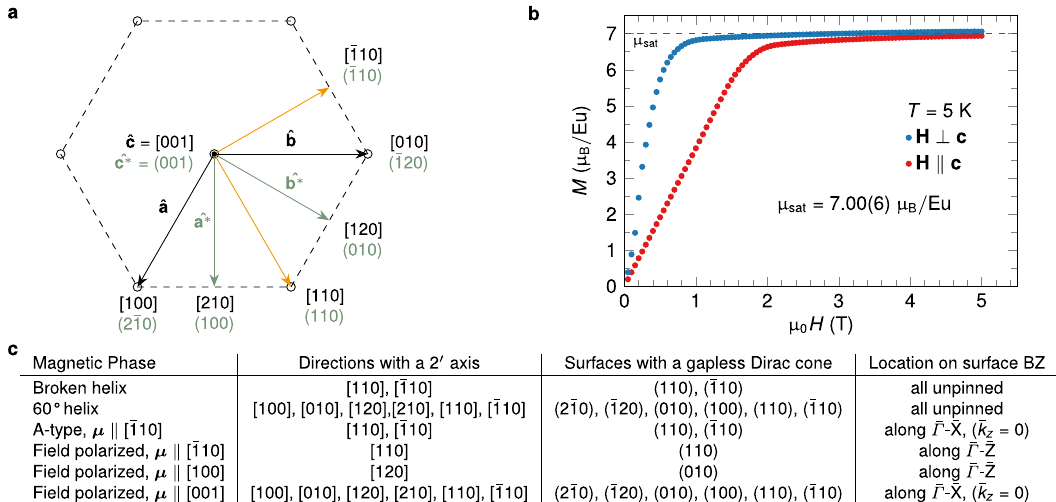
Fig. 4 Tuning surface Dirac cones via an applied magnetic fi eld. a Diagram showing real-space (denoted by brackets) and reciprocal-space (denoted by parentheses) directions for the ab plane. The magnetic orthorhombic unit cells for broken-helix and A-type orders discussed in the main text have their a orth and b orth axes along ½ (cid:1) 110 (cid:2) and − [110], respectively. b Magnetization versus magnetic fi eld curves for a temperature of T = 5 K and the fi eld applied either perpendicular or parallel to c . c A table indicating the 2 0 axis/axes, the surface(s) containing a gapless Dirac cone, and the location of the gapless Dirac cone on the projected surface-Brillouin Zone(s) (BZ) for various zero- fi eld and fi eld-polarized magnetic states. The direction of the ordered magnetic moment μ is indicated where appropriate. The results for the broken-helix and 60 ∘ -helix phases assume that the blue Eu layers lie along ½ (cid:1) 110 (cid:2) (cid:1) insulator, the gapless surface Dirac cones on (110) and ð 110 Þ order phases. In particular, Fig. 4c shows that the pure 60 ∘ -helix support dissipationless charge transport where sweeping E F phase supports multiple surfaces with an unpinned gapless Dirac through the Dirac point switches the handedness of the chirality cone. The consequences of the gapless Dirac cones being exoti- associated with the itinerant charge. Similar analyses of the sur- cally unpinned from TRIM, which require abscence of Kramer ’ s face states can be performed for the pure 60 ∘ -helix and A-type degeneracy, however, lacks investigation.